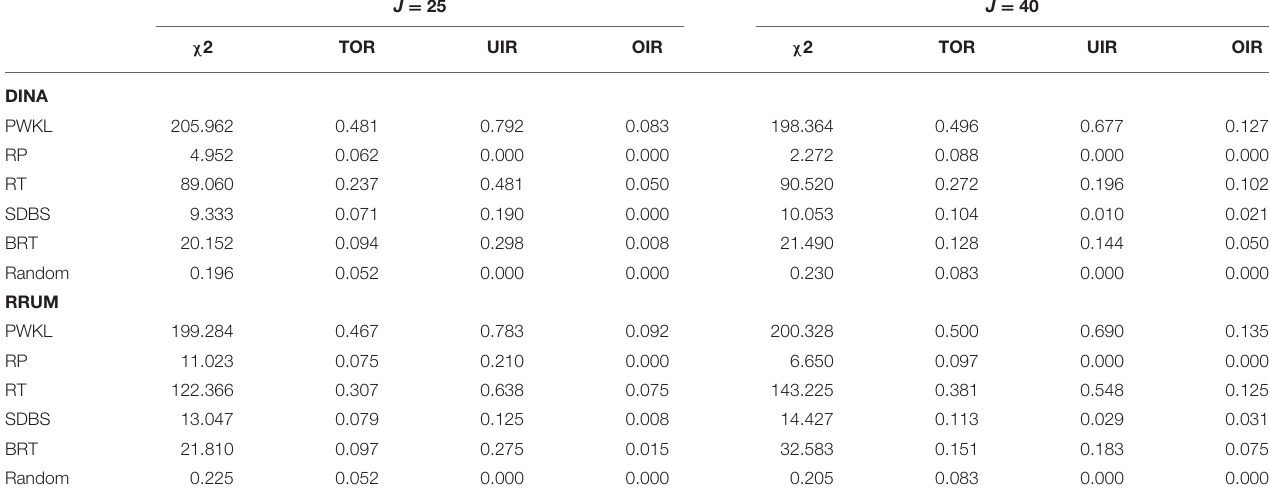
TABLE 4 | The usage of items for six